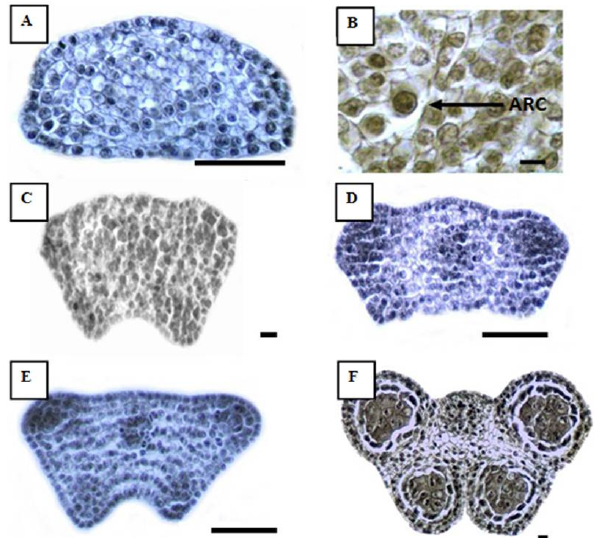
Fig. 2. Ontogeny of an anther in transverse sections of H. annuus L. A- Undifferentiated anther; B- Archesporial cell with prominent nucleus and dense cytoplasm; C- The anther become slightly lobed; D- Sporogenous tissue started to become visible; E- General view of four-lobed anther; F- Mature, tetrasporangiate anther with four pollen sacs; ARC: Archesporial cell. Bar: 10 µ m (B, C, F) and 100 µ m (A, D,